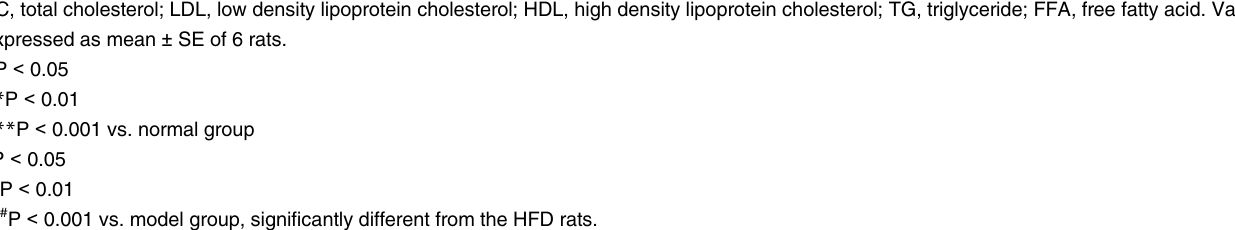
Table 1. Effect of acetylshikonin on biochemical parameters of serum in HFD induced obese rats. Normal HFD HFD+low AS HFD+middle AS HFD+high AS TC (mM) 1.24 ± 0.10 1.68 ± 0.33 * 1.48 ± 0.28 1.38 ± 0.25 1.64 ± 0.28 LDL (mM) 0.25 ± 0.03 0.58 ± 0.19 ** 0.51 ± 0.12 0.41 ± 0.18 0.49 ± 0.14 HDL (mM) 0.65 ± 0.03 0.48 ± 0.09 ** 0.45 ± 0.09 0.45 ± 0.09 0.51 ± 0.08 TG (mM) 0.79 ± 0.17 1.21 ± 0.10 *** 1.11 ± 0.32 0.93 ± 0.29 # 0.73 ± 0.27 ## FFA (mM) 0.43 ± 0.27 0.70 ± 0.32 ** 0.62 ± 0.29 0.51 ± 0.41 # 0.49 ± 0.12